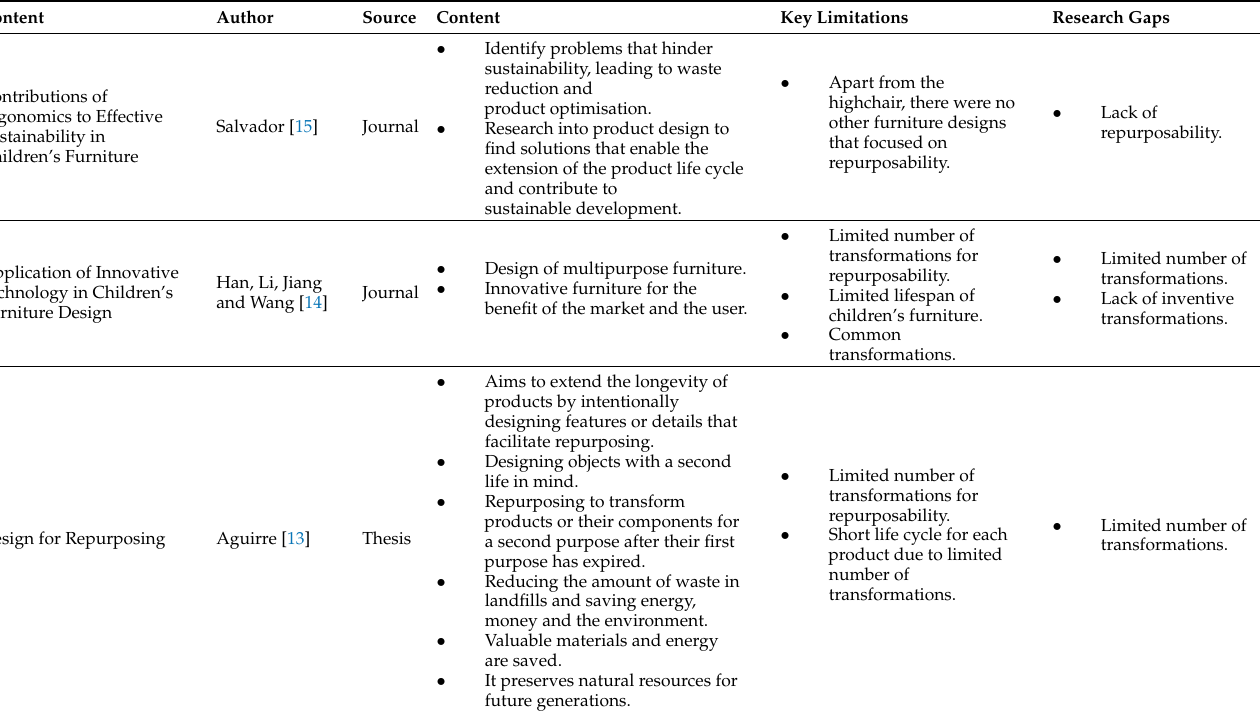
Table 2. Summary of the literature synthesis and research gaps for more recent